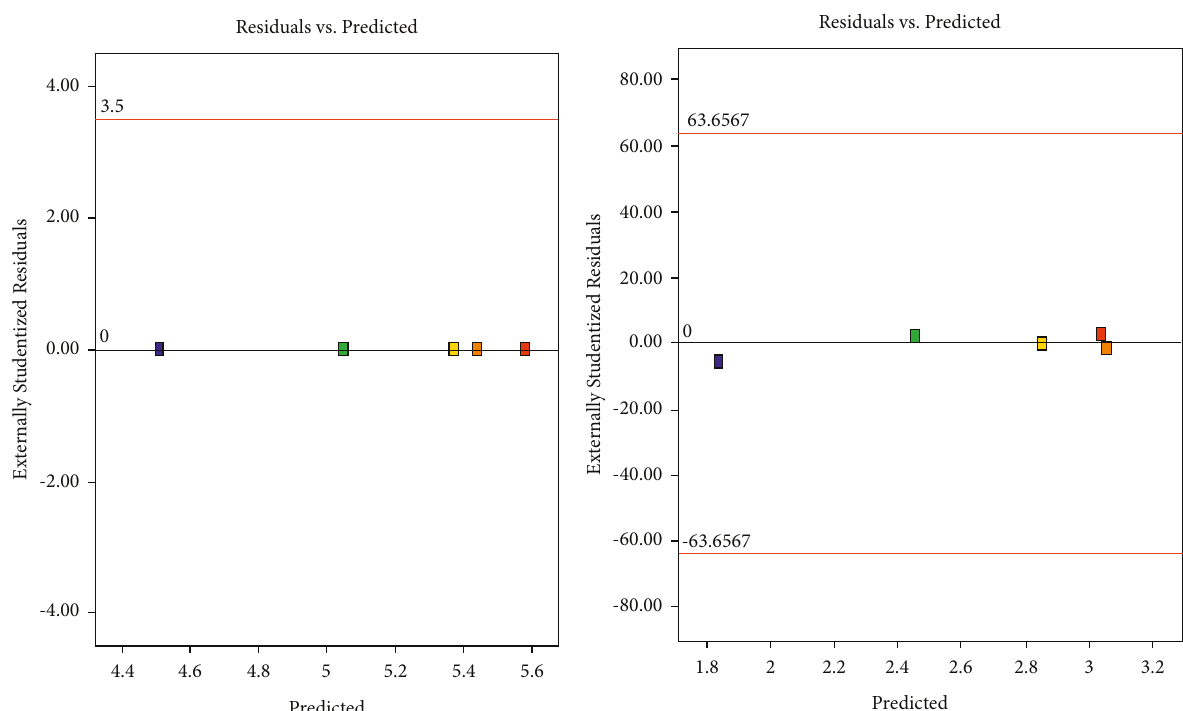
Figure 9: Residual vs. predicted diagnostic statistical